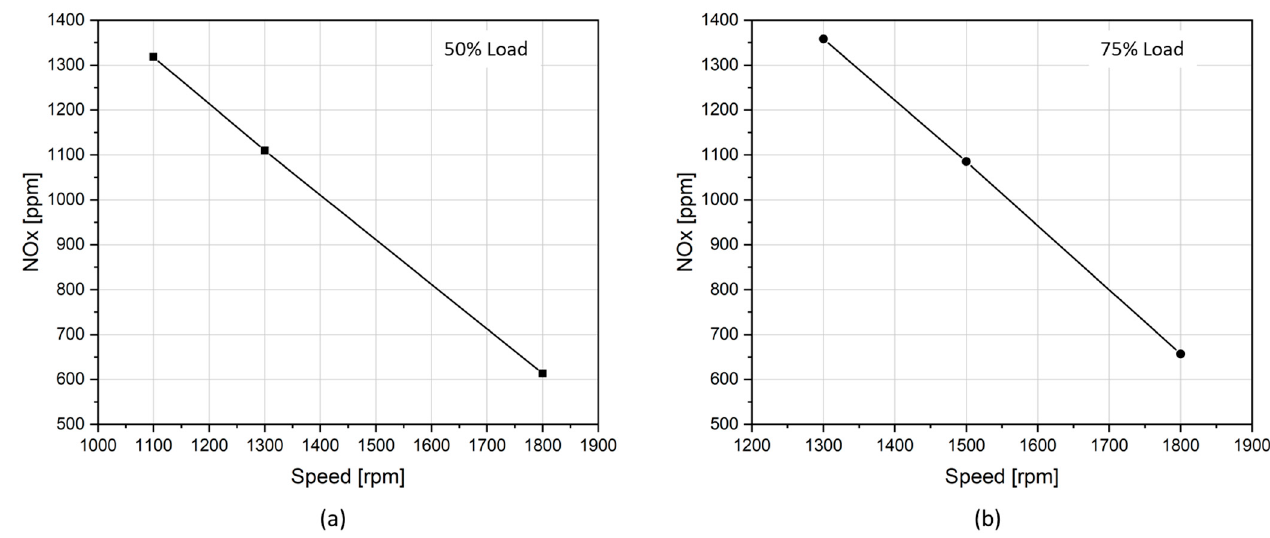
Figure 7. NOx emission according to different engine speeds at ( a ) 50% and ( b ) 75% load.